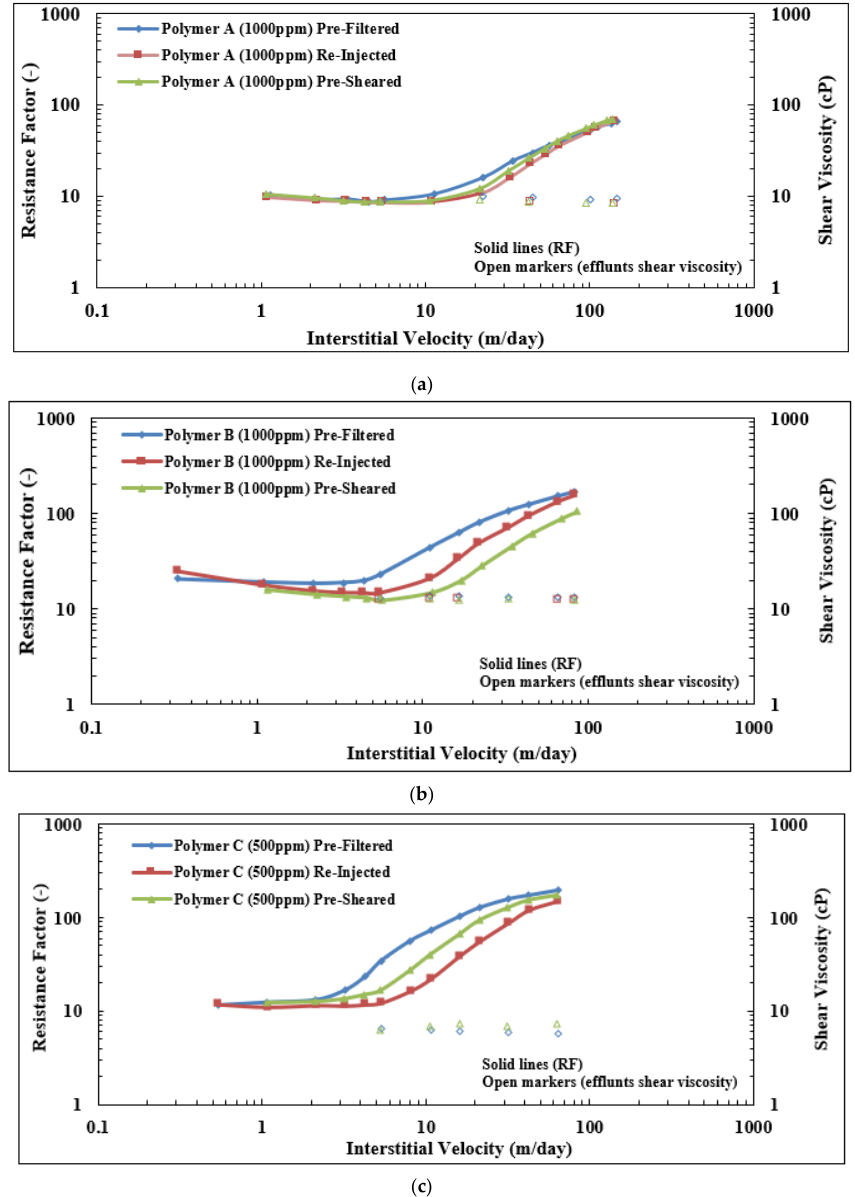
Figure 6. Resistance factor versus interstitial velocity for semi-dilute polymers A, B and C. Open markers indicate effluent shear viscosity for the given velocity measured at γ(cid:4662) = 10 (cid:1871) (cid:2879)(cid:2869) . ( a ) Polymer A (Mw ≈ 8 MDa, Concentration = 1000 ppm); ( b ) Polymer B (Mw ≈ 12 MDa, Concentration = 1000 ppm); ( c ) Polymer C (Mw ≈ 18 MDa, Concentration = 500